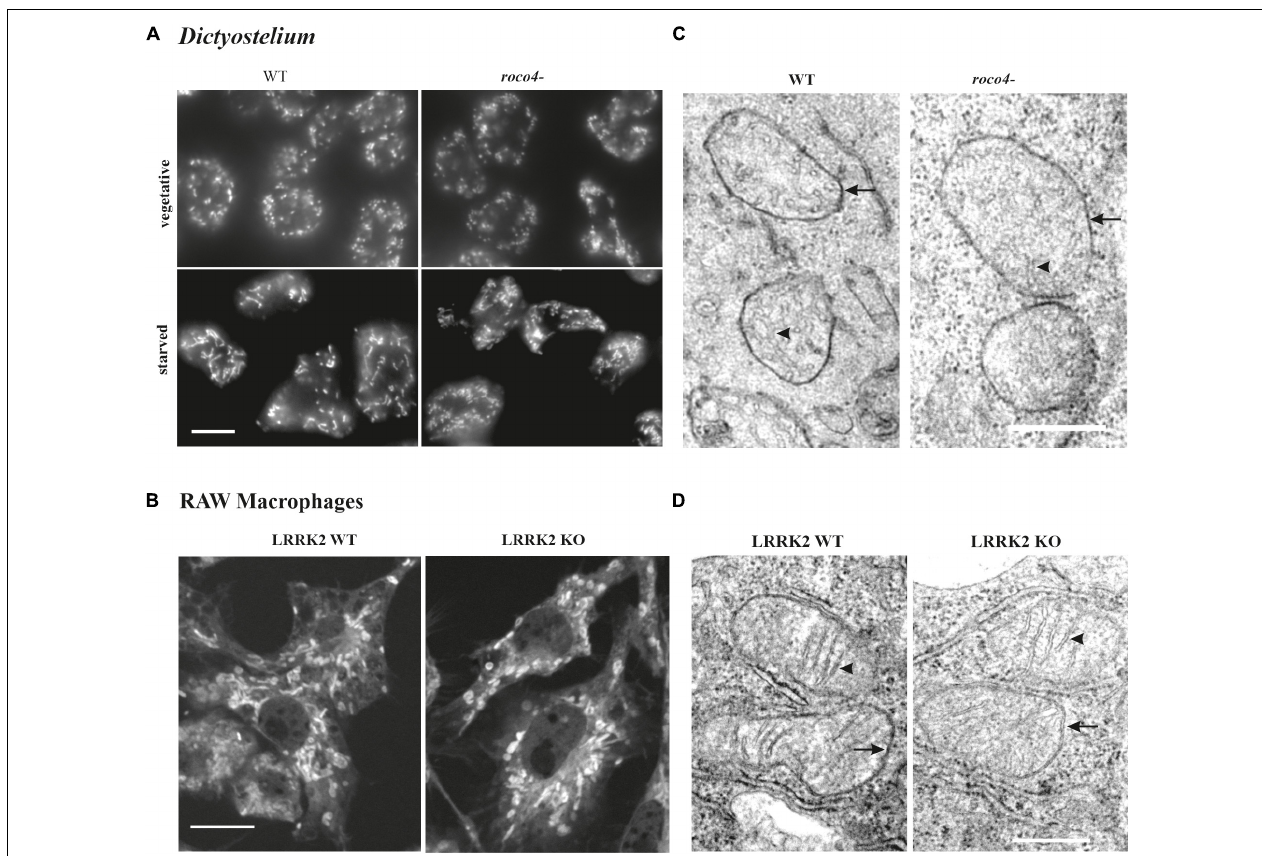
FIGURE 5 | Disruption of Roco4 or LRRK2 does not affect the number and morphology of mitochondria. (A) D. discoideum WT and roco4- cells in vegetative state and after starvation, stained with Alexa-594 conjugated streptavidin. Scale bar indicates 10 µ m. (B) Macrophages, LRRK2 parental and LRRK2-KO strains, stained with MitoTrackerTM Deep Red. Scale bar indicates 10 µ m. (C,D) TEM images of mitochondria in the respective D. discoideum (C) and macrophage (D) cells. The mitochondrial inner and outer membrane layers are indicated with arrows whereas cristae with arrowheads. Scale bars indicate 1 µ